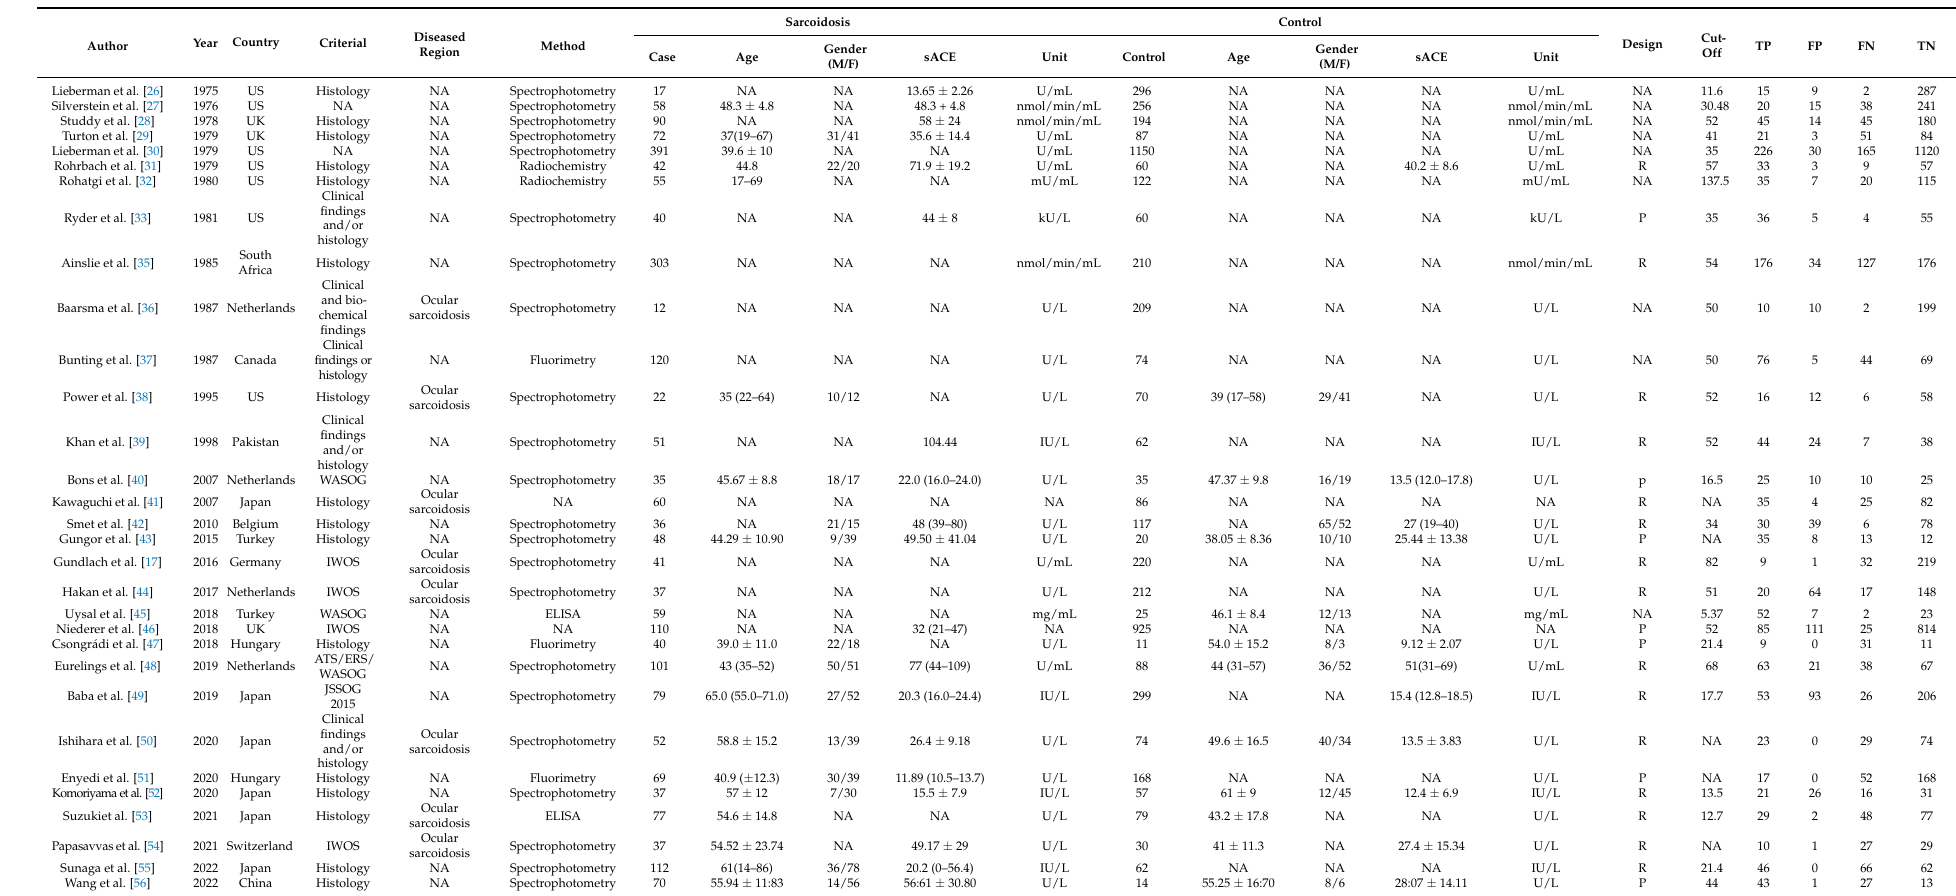
Table 1. The clinical summary of included studies for